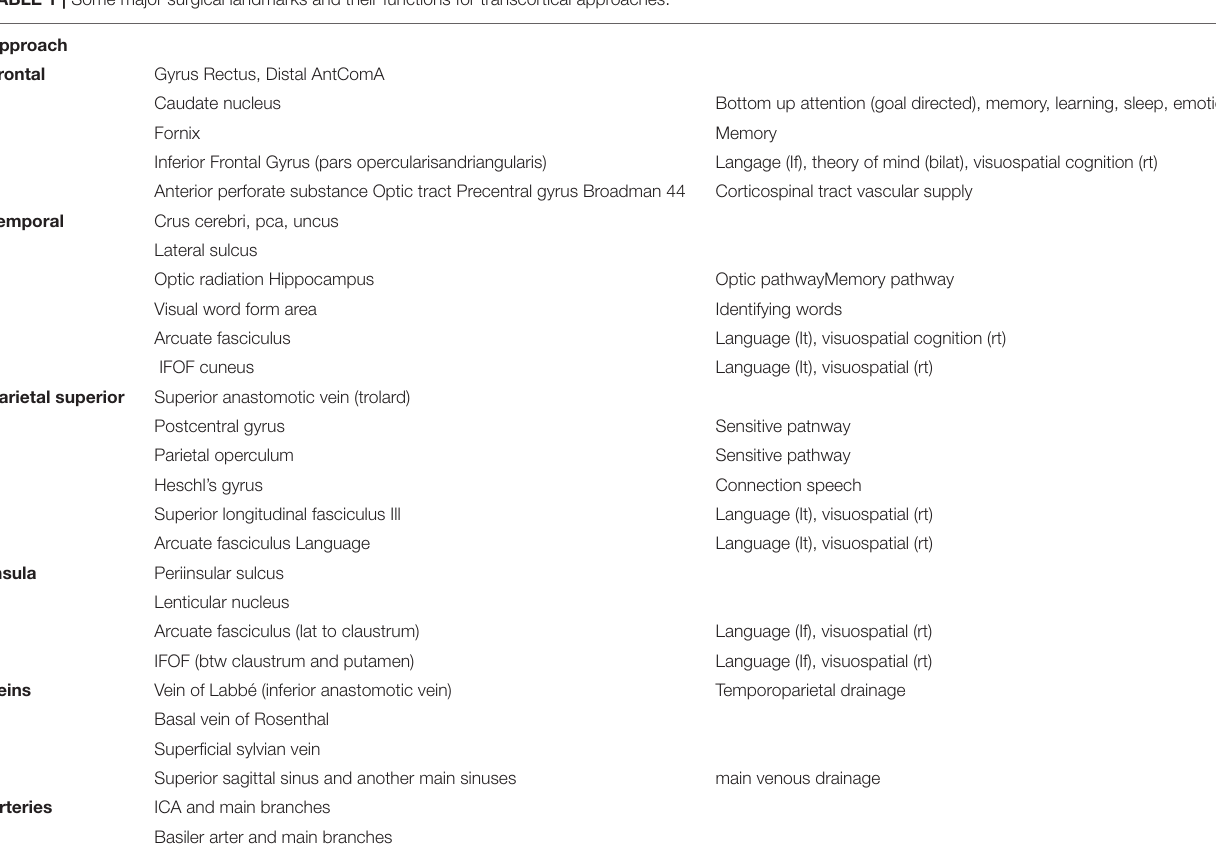
TABLE 1 | Some major surgical landmarks and their functions for transcortical approaches.